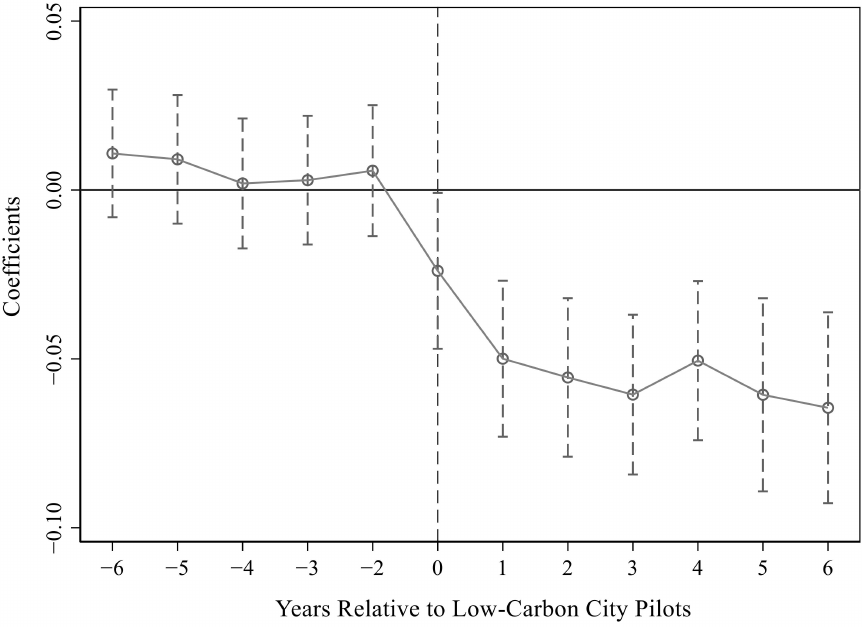
Figure 5. Parallel trend test in the second column of Table